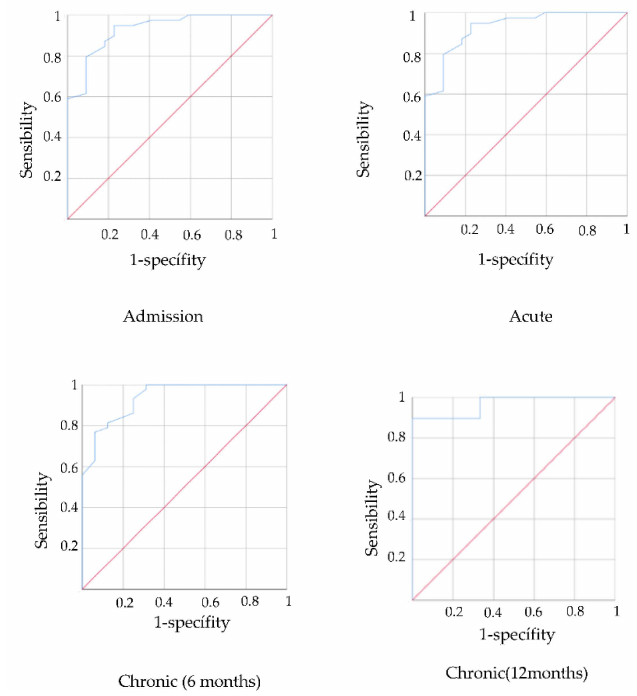
Figure 1. ROC curves predictive validity PASS for functionality in acute, subacute and chronic stage.